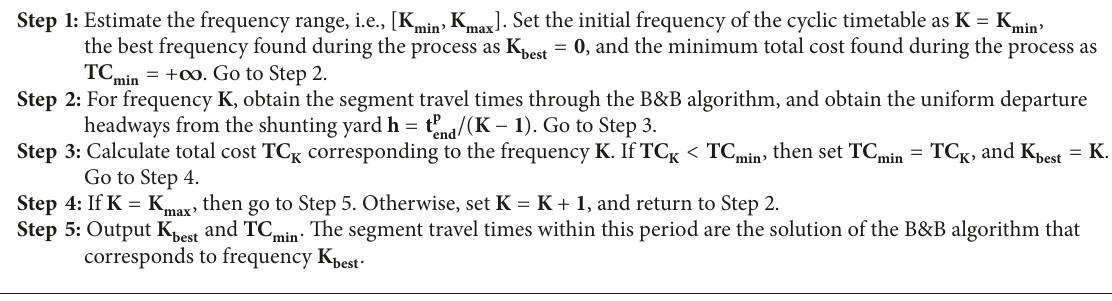
Algorithm 1: Frequency determining algorithm.